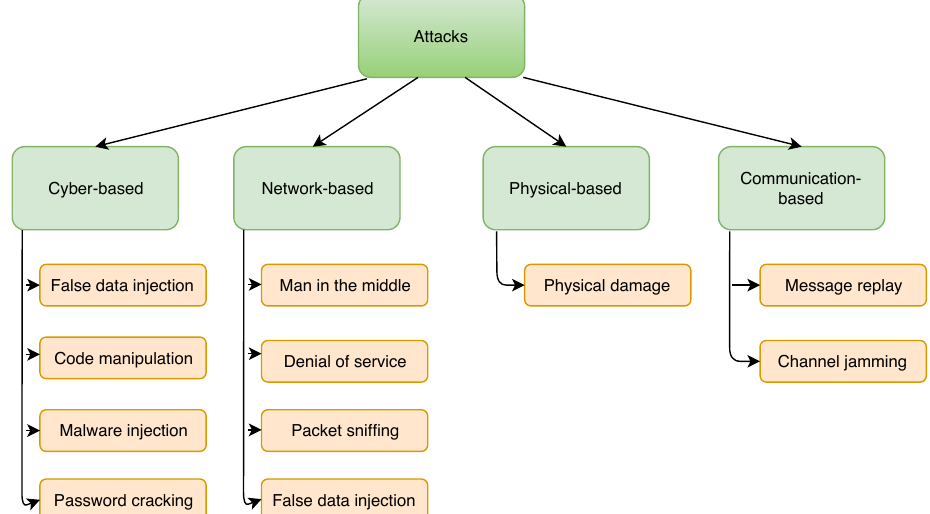
Figure 1. Classifications of attacks in energy industry